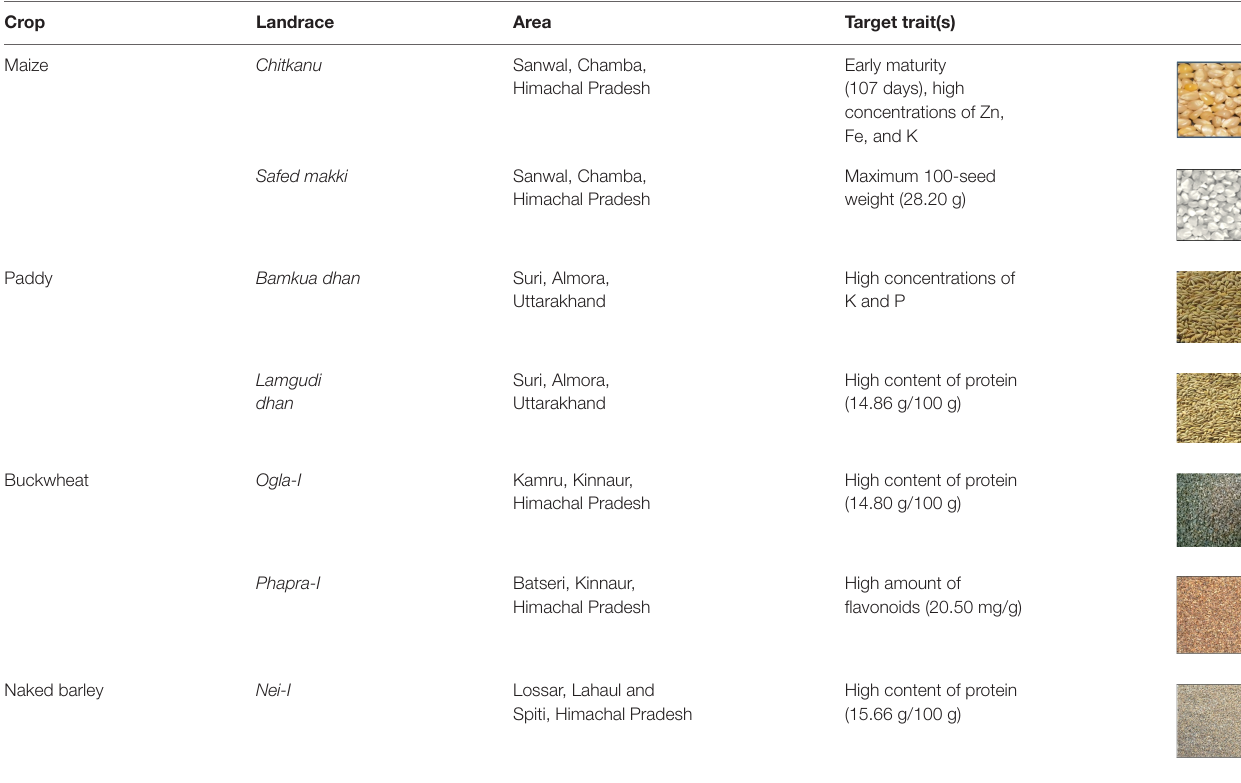
TABLE 4 | Identification of elite traditional crop landraces for mainstream agriculture. Crop Landrace Area Target trait(s)